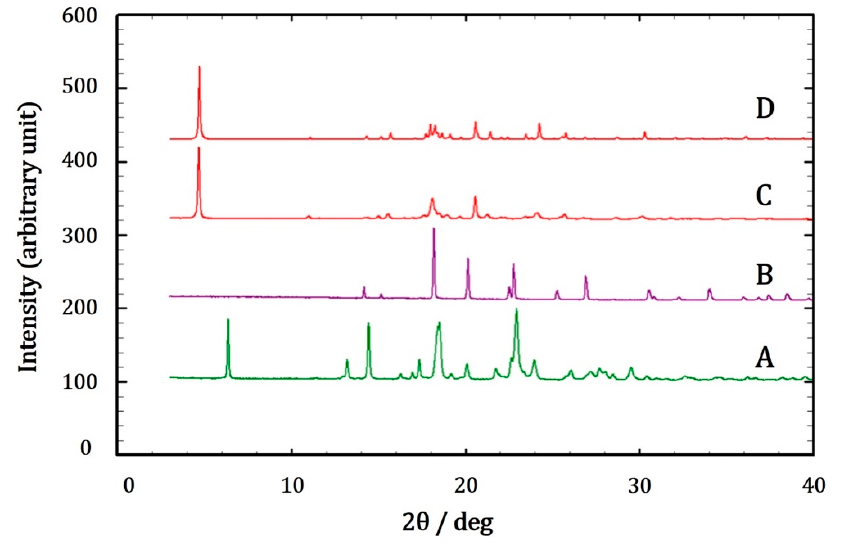
Figure 2. X-ray diffraction patterns: ( A ) ketoprofen (experiment), ( B ) tromethamine (experiment), ( C ) ketoprofen–tromethamine MCC (experiment), and ( D ) ketoprofen–tromethamine CC (simulation). C and D are almost identical.